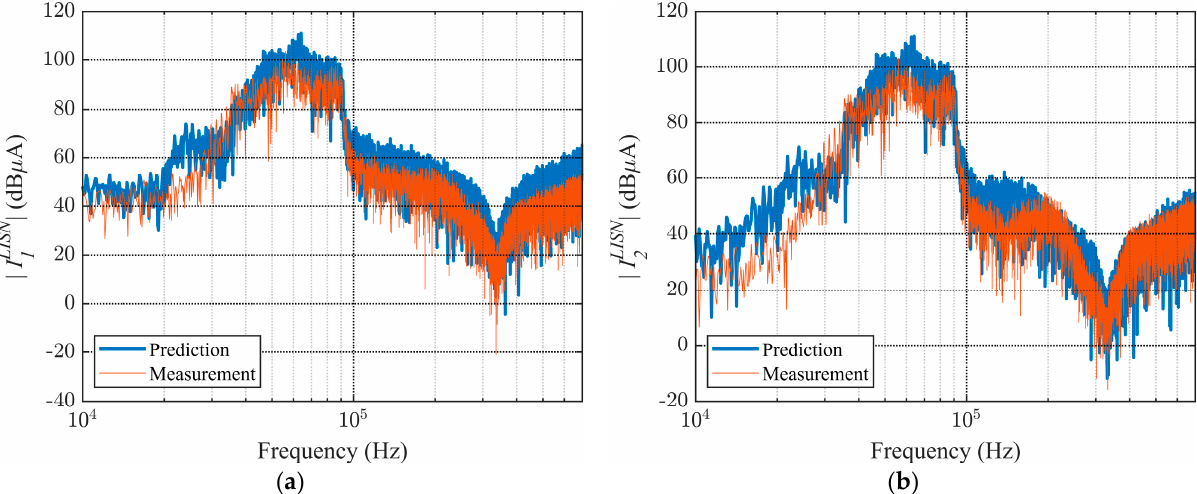
Figure 18. Currents ( a ) I LISN and ( b ) I LISN obtained from the prediction model and measurement data in test case #2 (with LISN B2). The PLC Tx modem is represented according to Section 5. Table 3. MAEs of the current curves shown in Figures 13, 14, 17 and 18.